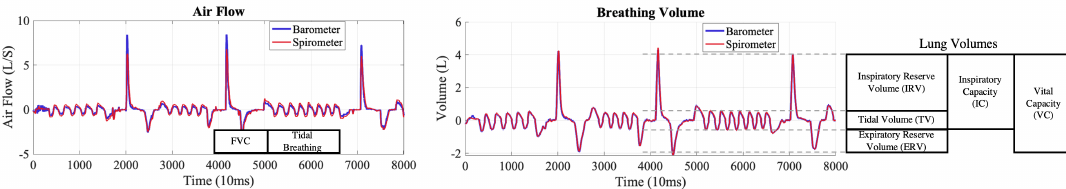
Figure 3. The airflow and air volume of three consecutive FVC maneuvers, with normal tidal breathing in between. The spirometer’s signals are The original measurement; The barometer’s values are predicted with The inclusive-poly5